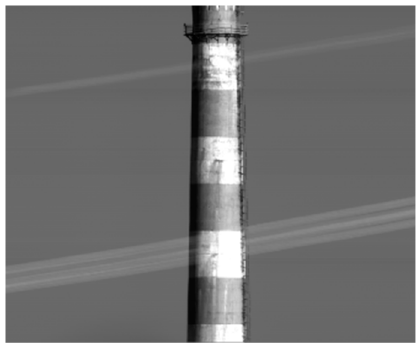
Figure 15. Experimental results of space camera out-of-field imaging.